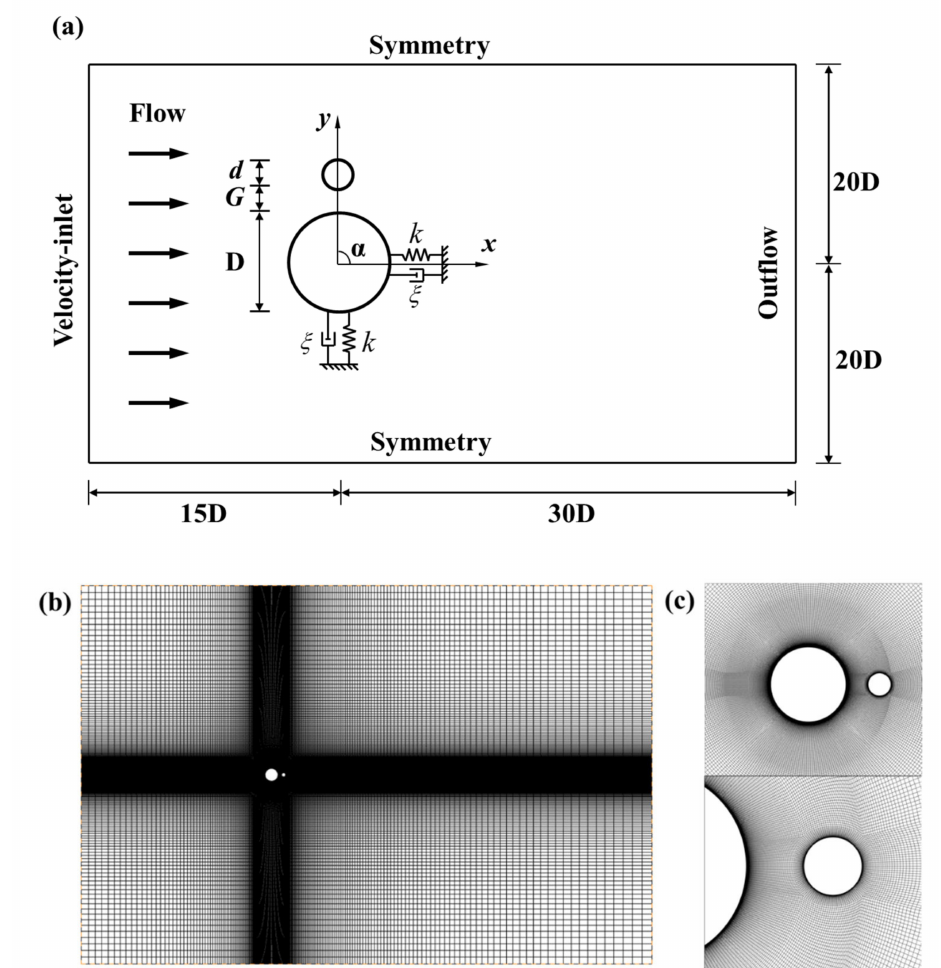
Figure 1. The schematics of computational domain of two coupled cylinders system: ( a ) sketch of the computational model ( α = 90 ◦ ); ( b ) computational mesh ( α = 0 ◦ and d/D = 0.3); ( c ) mesh details around two coupled